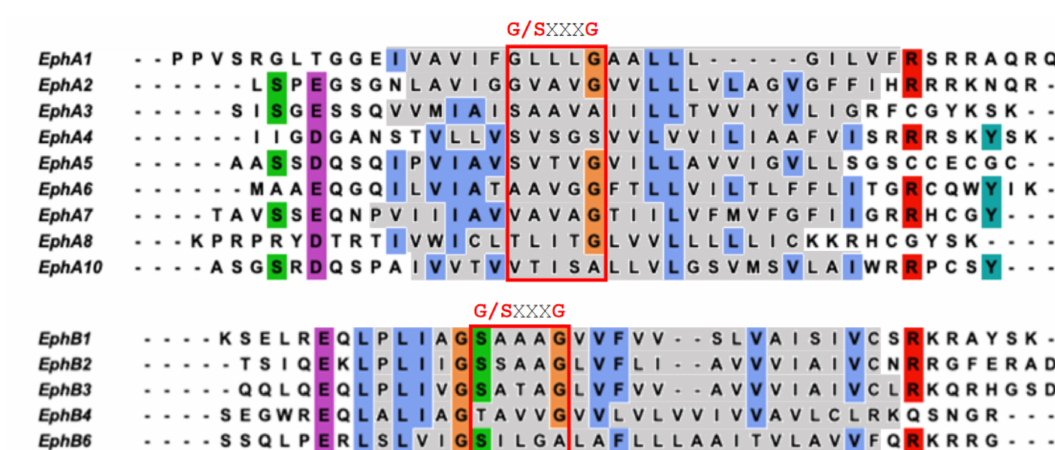
Figure 3. Sequence alignment of TMD of EphA and EphB receptors expressed in humans. The Small-X 3 -Small motif/Glycine zipper motifs are marked. Residues of the TM region are highlighted in grey. Conserved residues are shown in different